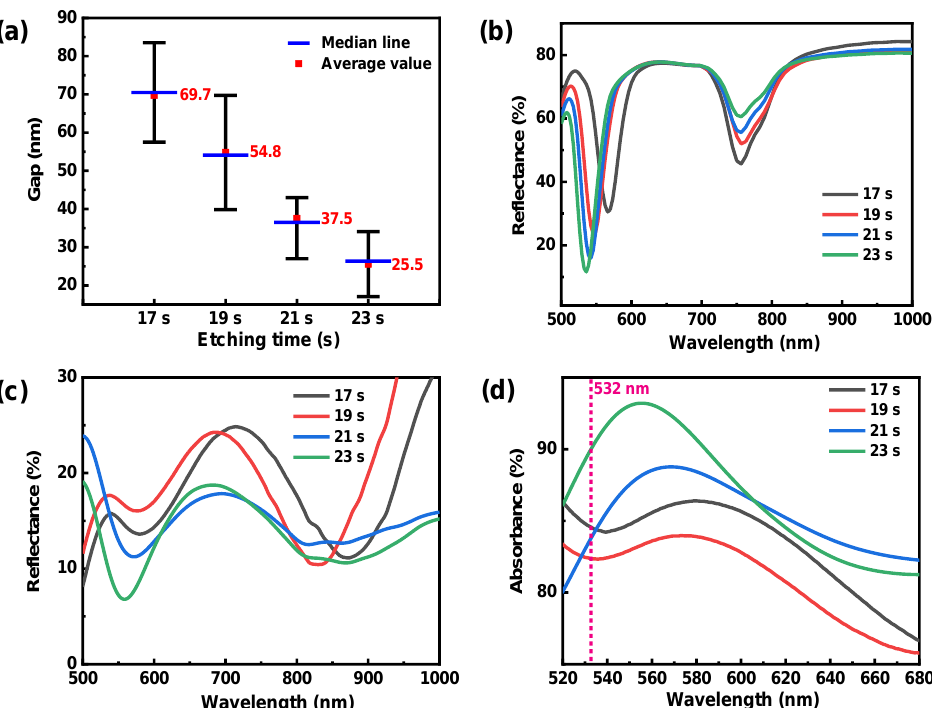
Figure 4. ( a ) Measured the gap distances between the adjacent nanotriangles at different etching times. ( b , c ) Simulated and measured reflection spectra of the MIM substrate with different gaps. ( d ) Measured absorbance spectra of the MIM substrate with different gaps.